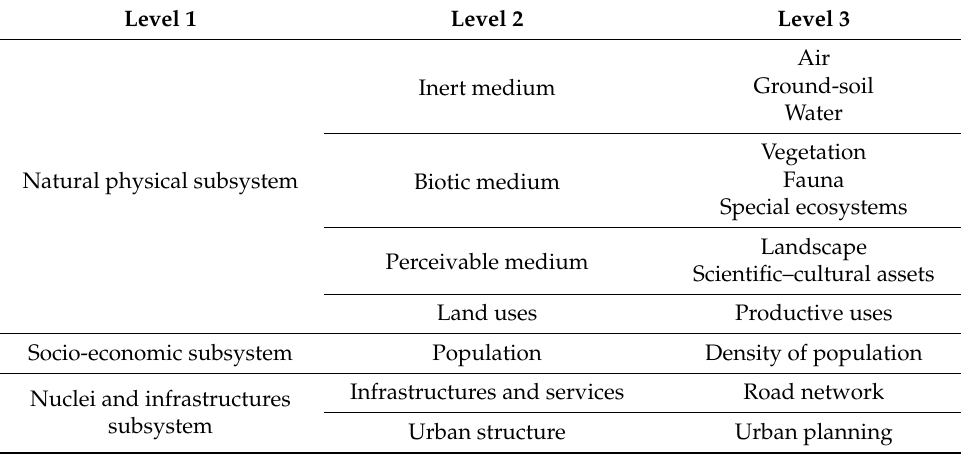
Table 1. Relation of components that are applied in this